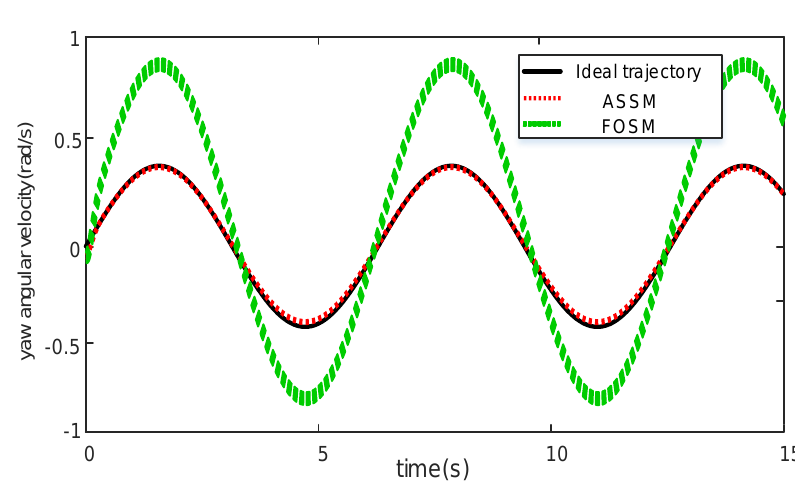
Figure 10. Yaw moment.